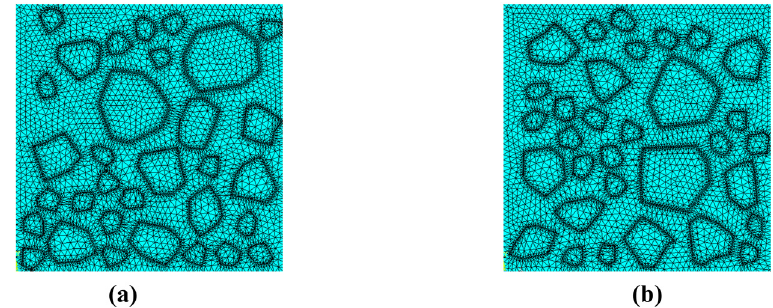
Figure 9: Two - dimensional random aggregate model: ( a ) FEM 2 and ( a ) FEM 3.